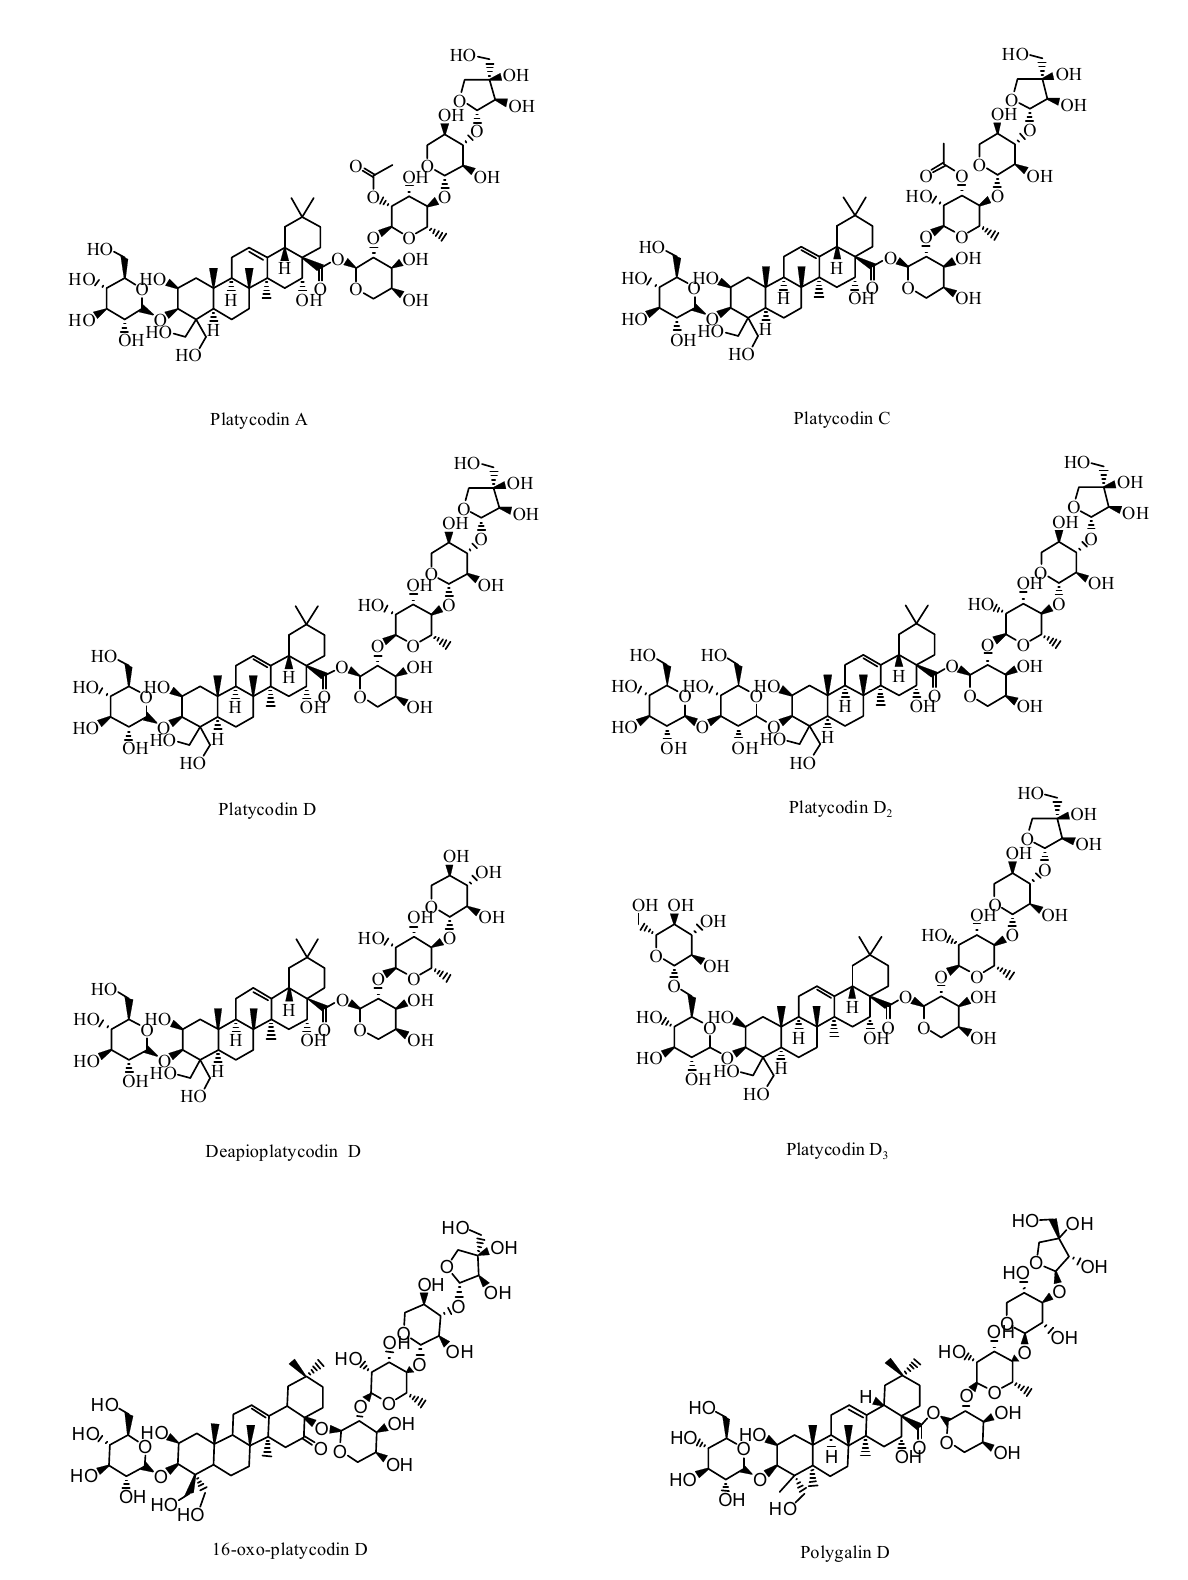
Figure 2. Active triterpenoid saponins in P. grandiflorus.